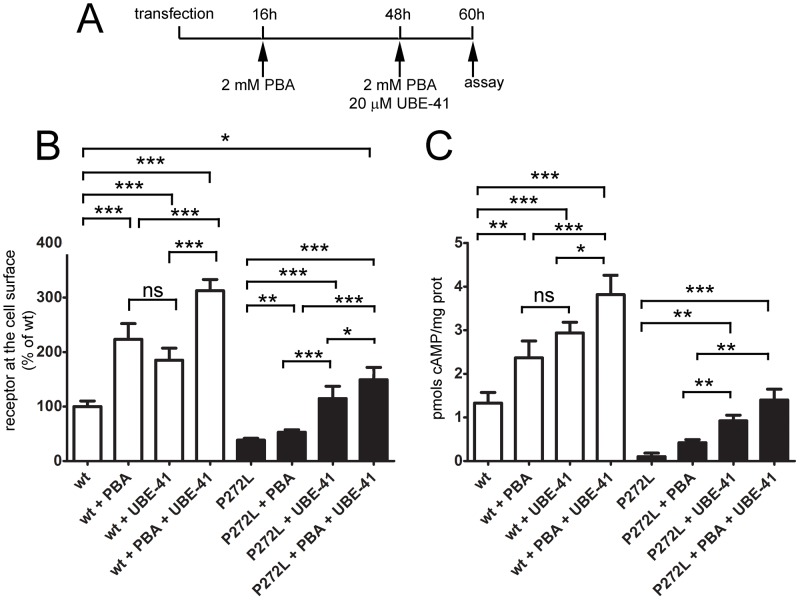
Functional studies and rescue of the mutation P272L.
A) N2A cells were transiently transfected with wt-HA-MC4R-GFP and mutated HA-MC4R-GFP-P272L and treated with vehicle or 2 mM PBA, 20 µM UBE-41 or both at the time points indicated in the diagram. B) Receptor at the cell surface from cells in A was measured by a spectrophotometric assay. Data are expressed as percentage of the wt without treatment, (n = 3). C) Intracellular cAMP from cells in A was measured by using the immunoassay kit by Assay Designs (San Diego, CA), following the manufacturer's instructions. The amount of cAMP generated by was expressed as pmols cAMP/mg protein, (n = 3). Statistical significance, * = p<0.05,** = p<0.001,*** = p<0.0001, ns = p>0.05.